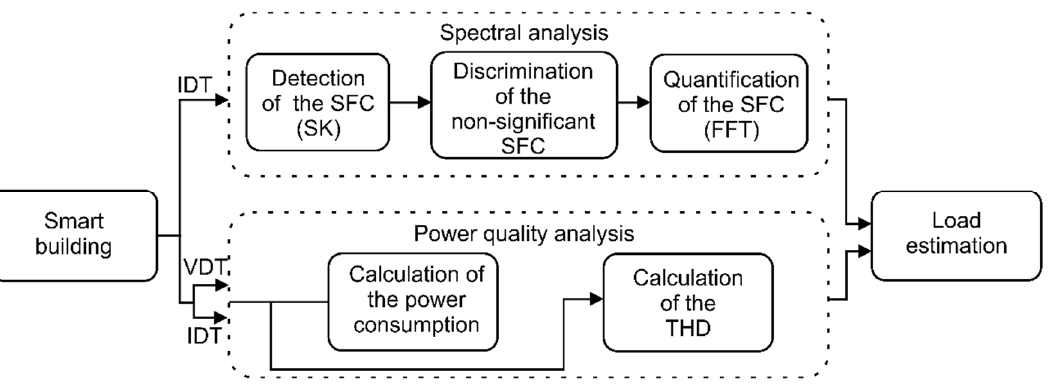
Figure 3. Description of the proposed methodology.